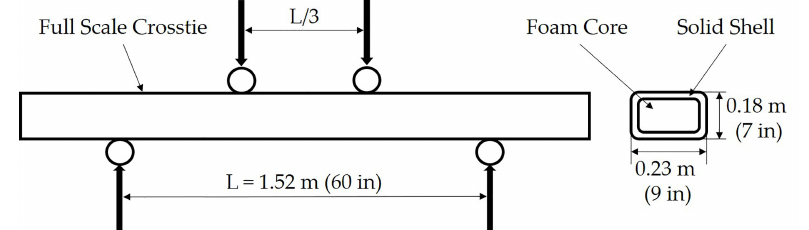
Figure 8. Representative four-point bend test (dimensions for experimental and FEA